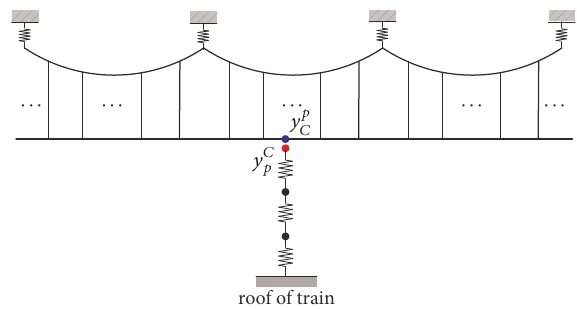
Figure 5: The contact between the pantograph and the contact